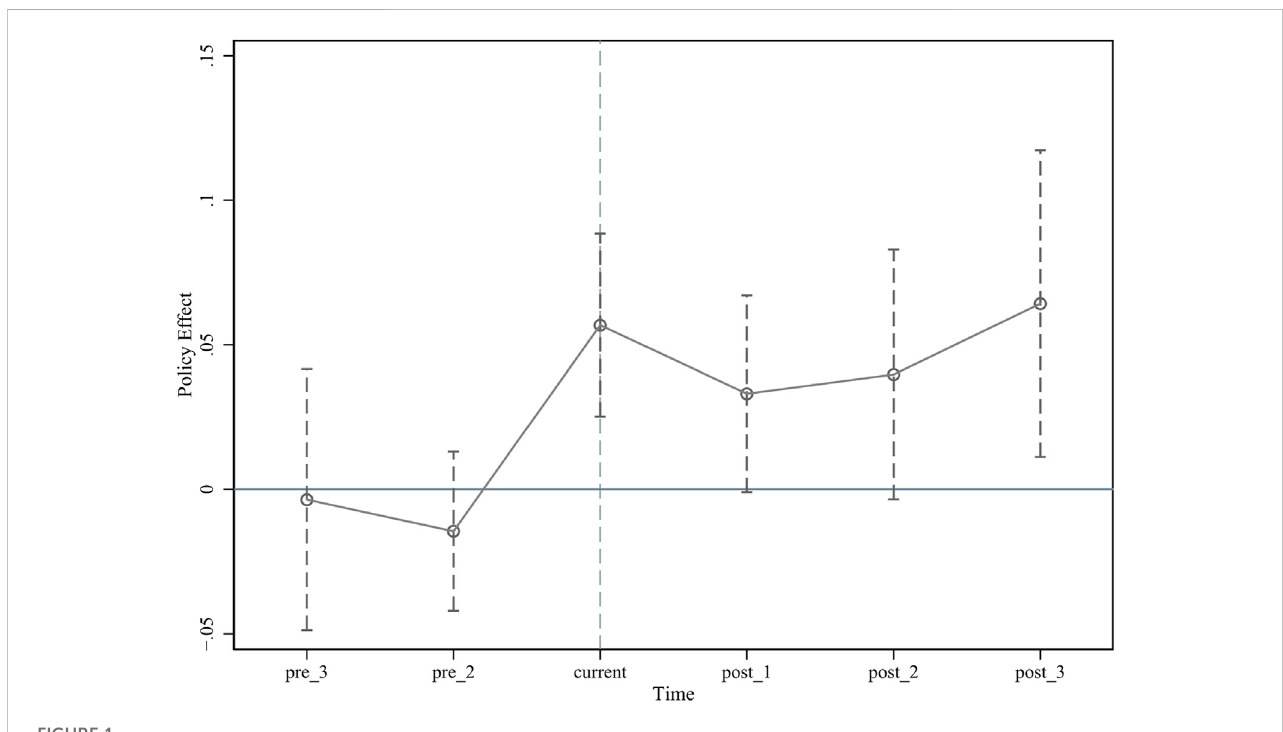
FIGURE 1 Parallel trend